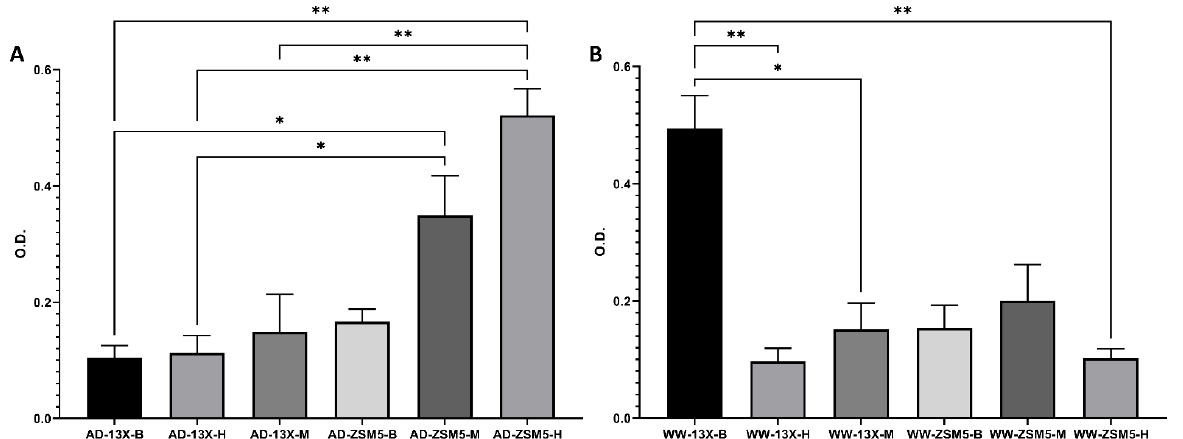
Figure 8. TCP analysis of biofilm extracted from ( A ) AD biocarriers and ( B ) WW biocarriers. ** p < 0.01; * p < 0.05. n = 3.